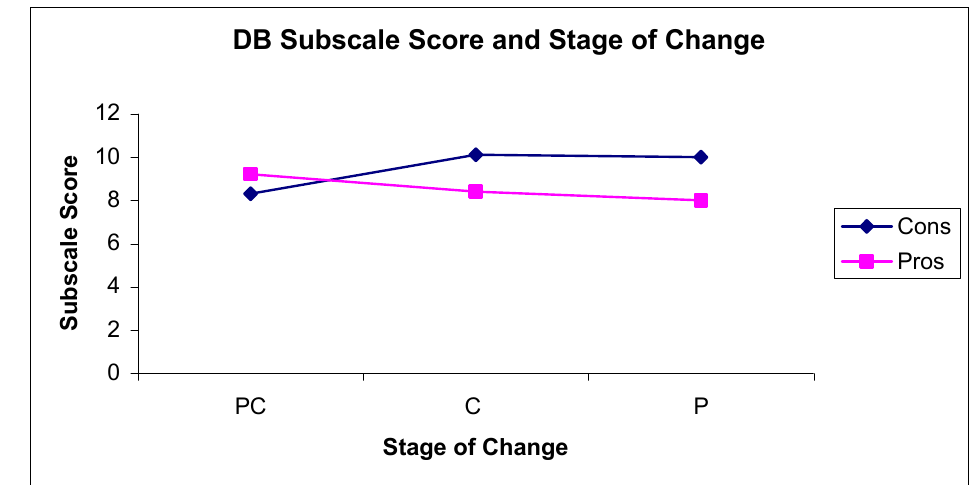
Figure 1. Mean Subscale Scores by Stage of